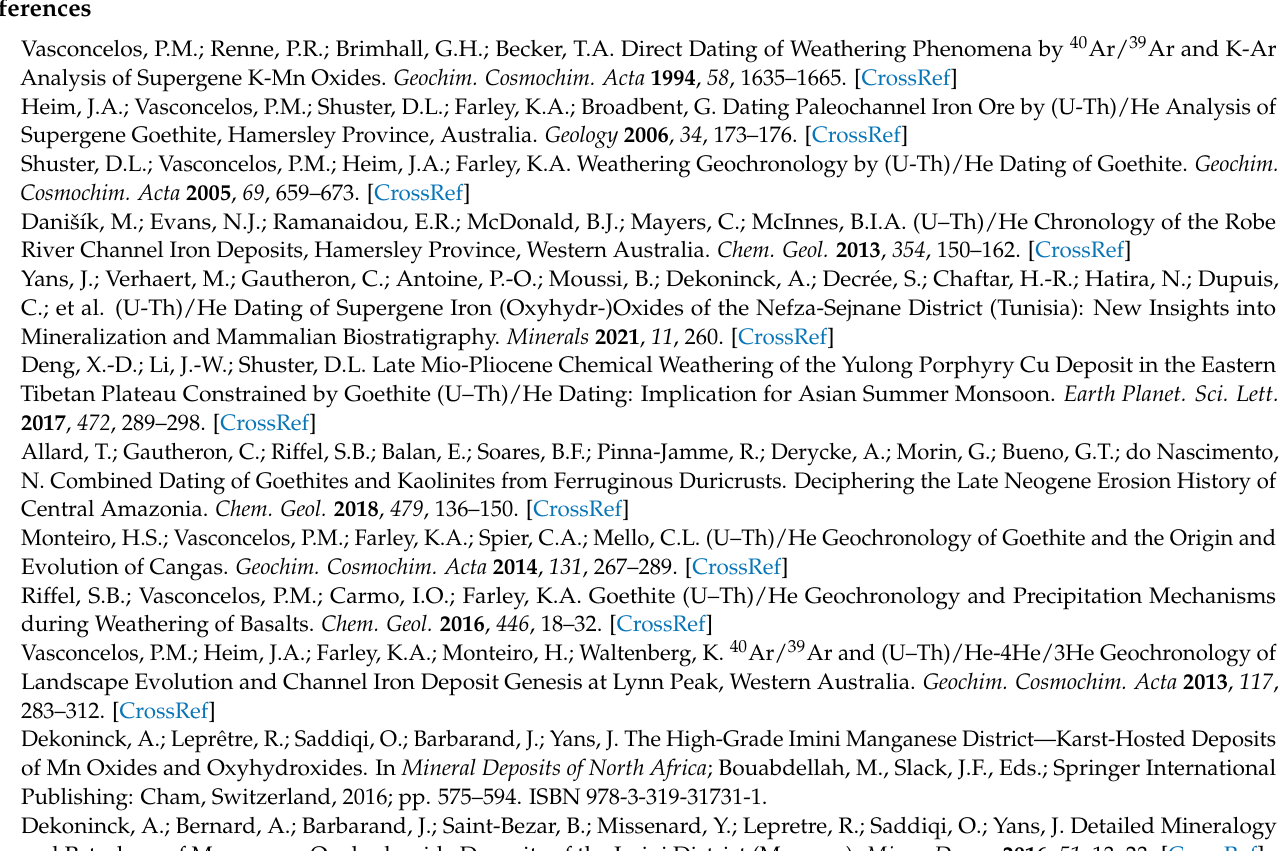
minor elements, Table S5: Oxygen and hydrogen isotopic compositions of Imini goethite, Table S6: Imini goethite (U-Th)/He